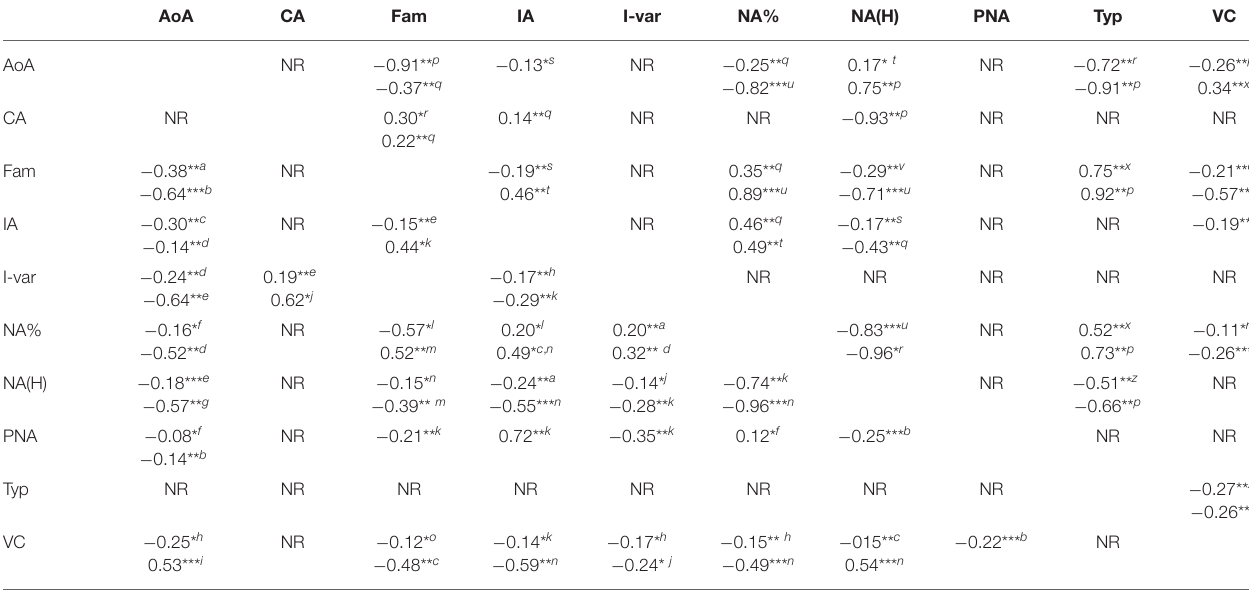
TABLE 3 | Significant correlations between dimensions in normative studies of line-drawings and photographs. AoA CA Fam